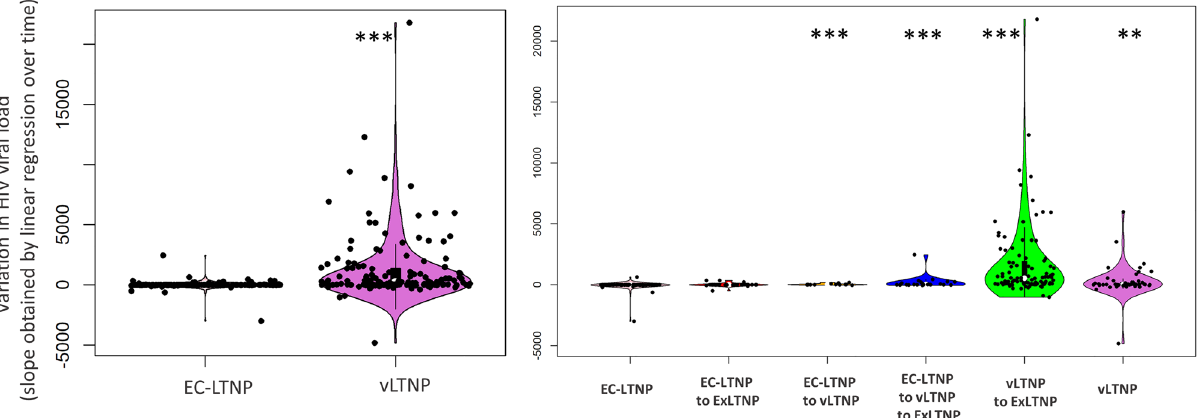
Figure 3. Variation of HIV VL during follow-up. Variation in HIV VL was expressed as the slope obtained by linear regression over time in individuals primarily classified as EC-LTNP or vLTNP (left panels) or as EC-LTNP maintaining their status, EC-LTNP losing LTNP status, EC-LTNP re-classified as vLTNP during follow-up, EC-LTNP primarily re-classified as vLTNP and then losing LTNP phenotype, vLTNP maintaining their status and vLTNP losing LTNP phenotype (right panels). Overall statistically significant differences were found in colored panels. * p < 0.05; ** p < 0.01; *** p < 0.001 compared to EC-LTNP or EC-LTNP maintaining the phenotype,